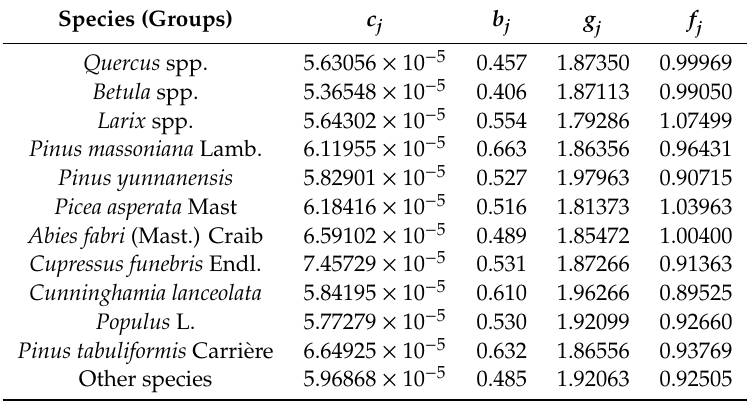
Table A1. Modeling parameters of Chinese tree species forest stock